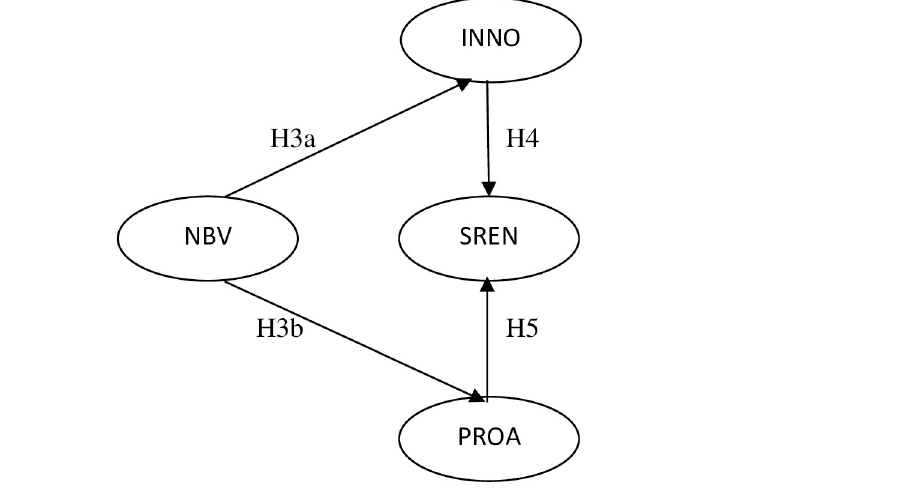
Fig 2. Conceptual model, Stage II. NBV = New Business Venturing, INNO = Innovation, PROA = Proactiveness, SREN = Self-renewal.